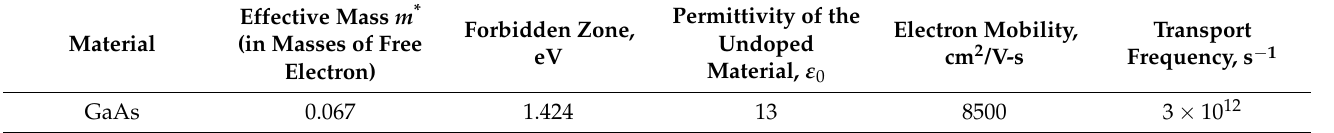
Table 1. Main parameters of GaAs semiconductor